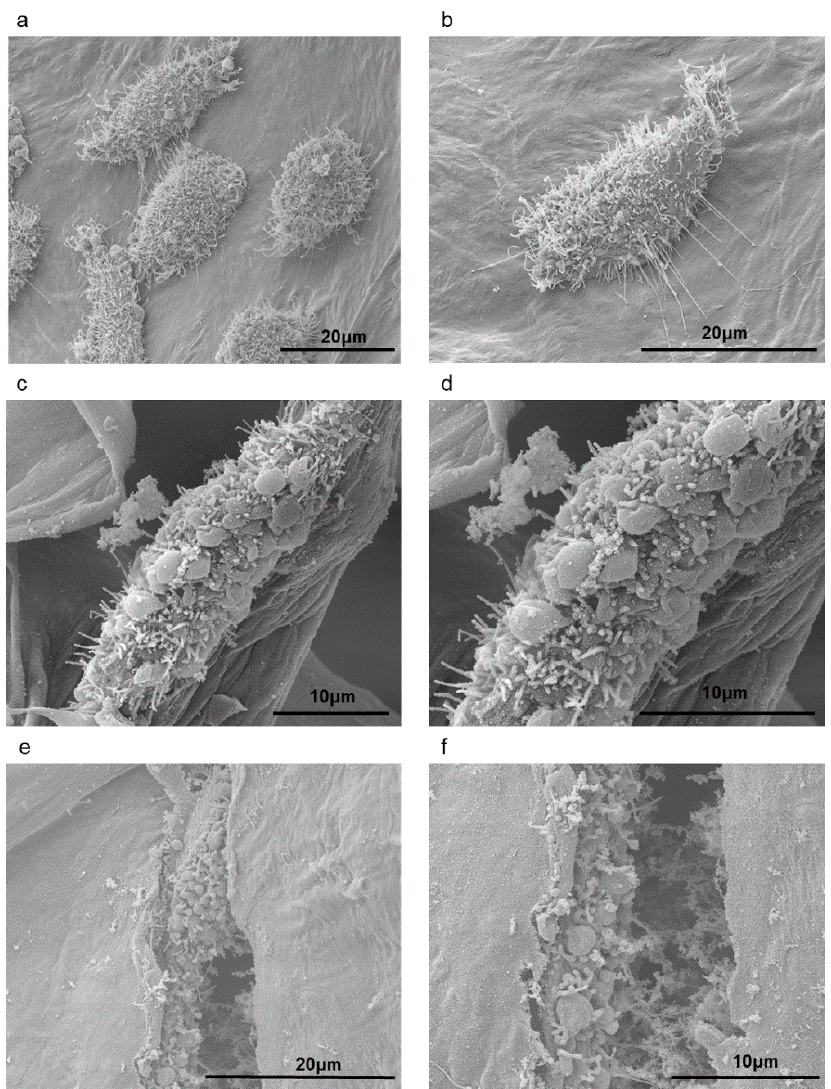
Figure 7. SEM micrographs of L929-fibroblast cells seeding on AlgCNFT50 gels: 2 days of incubation at 4000 × ( a ) and 6000 × magnification ( b ); 4 days of incubation at 4000 × ( c ) and 6000 × magnification ( d ); 7 days of incubation at 6000 × ( e ) and 10,000 × magnification ( f